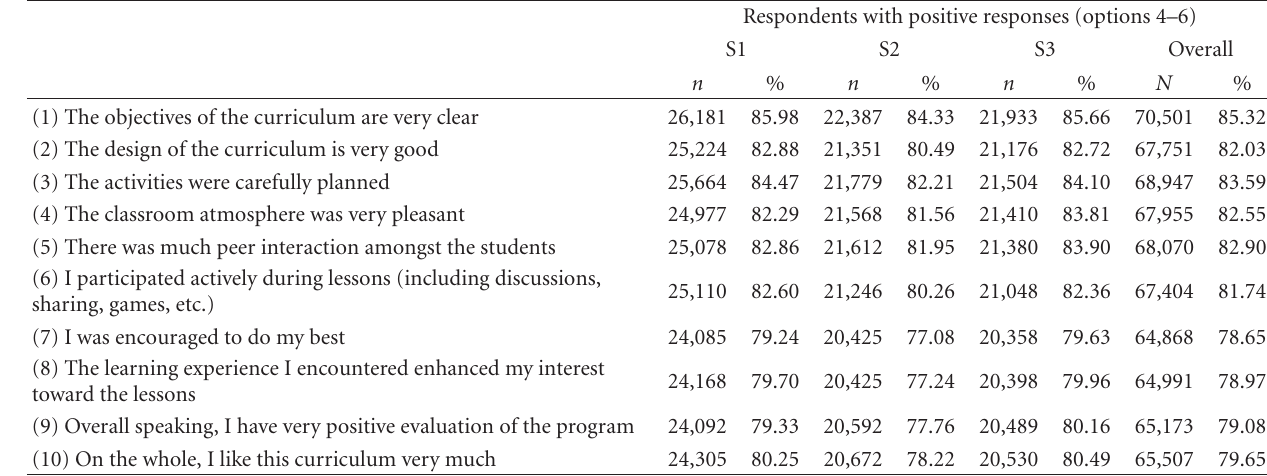
Table 1: Summary of the program participants’ perceptions toward the program